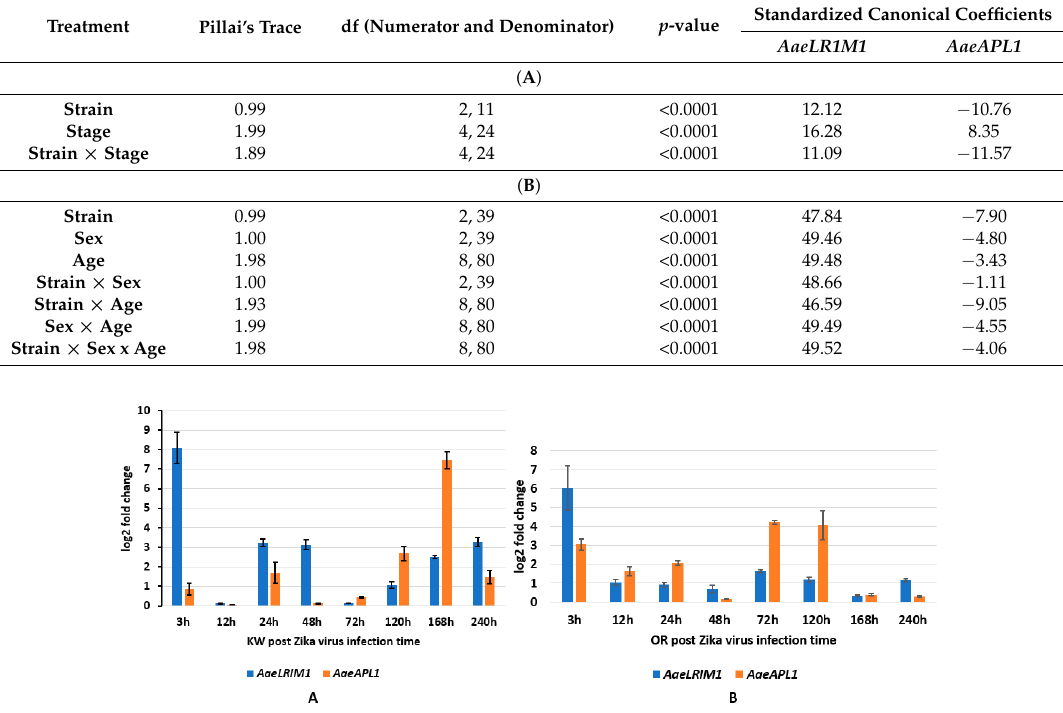
Figure 2. AaeLRIM1 and AaeAPL1 relative expression level fold changes in Aedes aegypti female infected with ZIKV. The fold change was calculated using the 2 [ − average ΔΔ CT] method. Δ Ct (Control) = Ct ( AaeLRIM1 / AaeAPL1 ) − Ct ( AeaActin ); Δ Ct (infected-ZIKV) = Ct ( AaeLRIM1 / AaeAPL1 ) − Ct ( AeaActin ); ΔΔ Ct = Δ Ct (infected-ZIKV) − Δ Ct (Control). The 3, 12, 24, 48, 72, 120, 168, and 240 h represented gene expression post infection with ZIKV. ( A ) Key West strain female Ae. aegypti ; ( B ) Orlando strain female Ae. aegypti . Table 2. ( A ) MANOVA results for strain and stage effects of the AaeLRIM1 and AaeAPL1 RNA profile 185 in immature stages of Ae. aegypti . ( B ) MANOVA results for strain, sex, and age effects of the AaeLRIM1 186 and AaeAPL1 RNA profile in adult stages of Ae. aegypti . 187